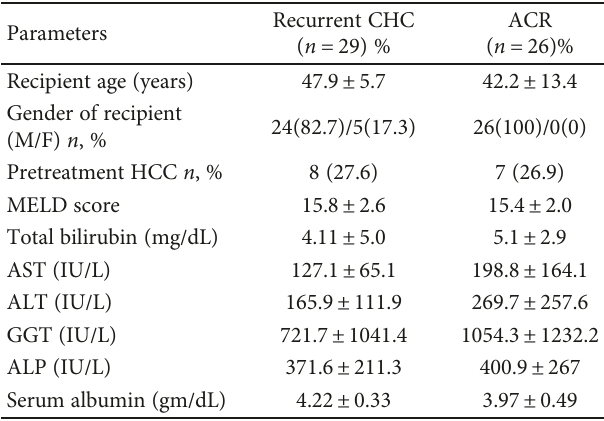
Table 1: Demographic and laboratory characteristics of patients with recurrent chronic hepatitis C (CHC) and acute cellular rejection